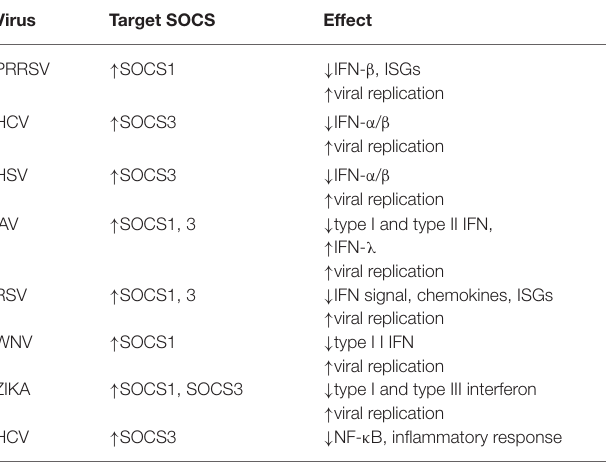
TABLE 1 | Virus Hijacking SOCS Proteins Escapes Innate Immunity.